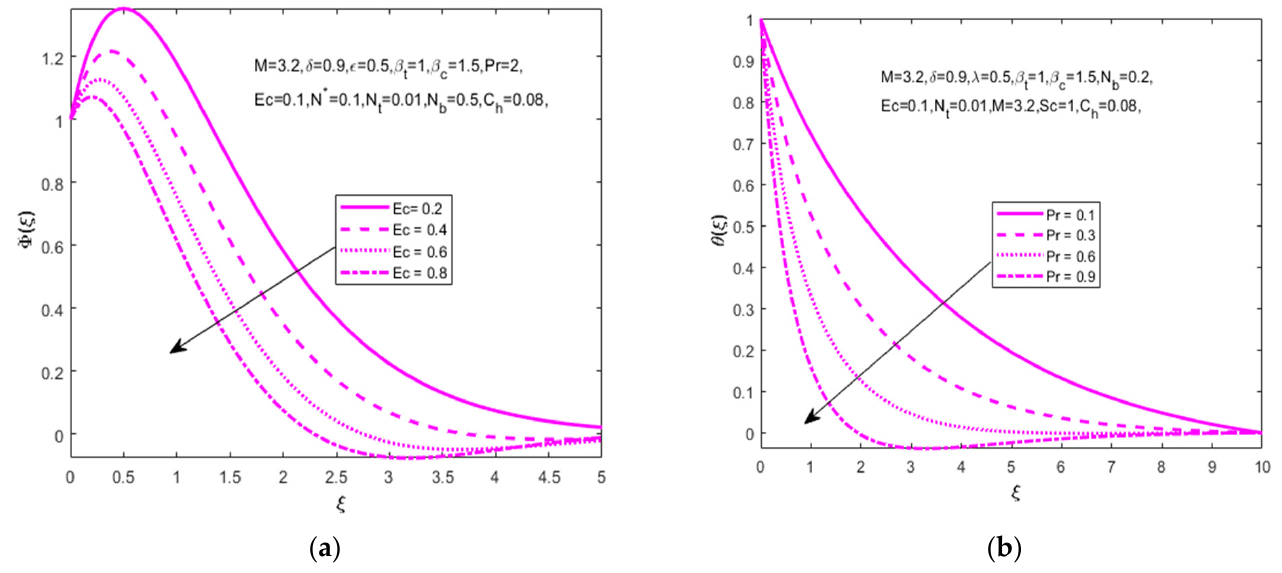
ξΦ and Prandtl number Pr on